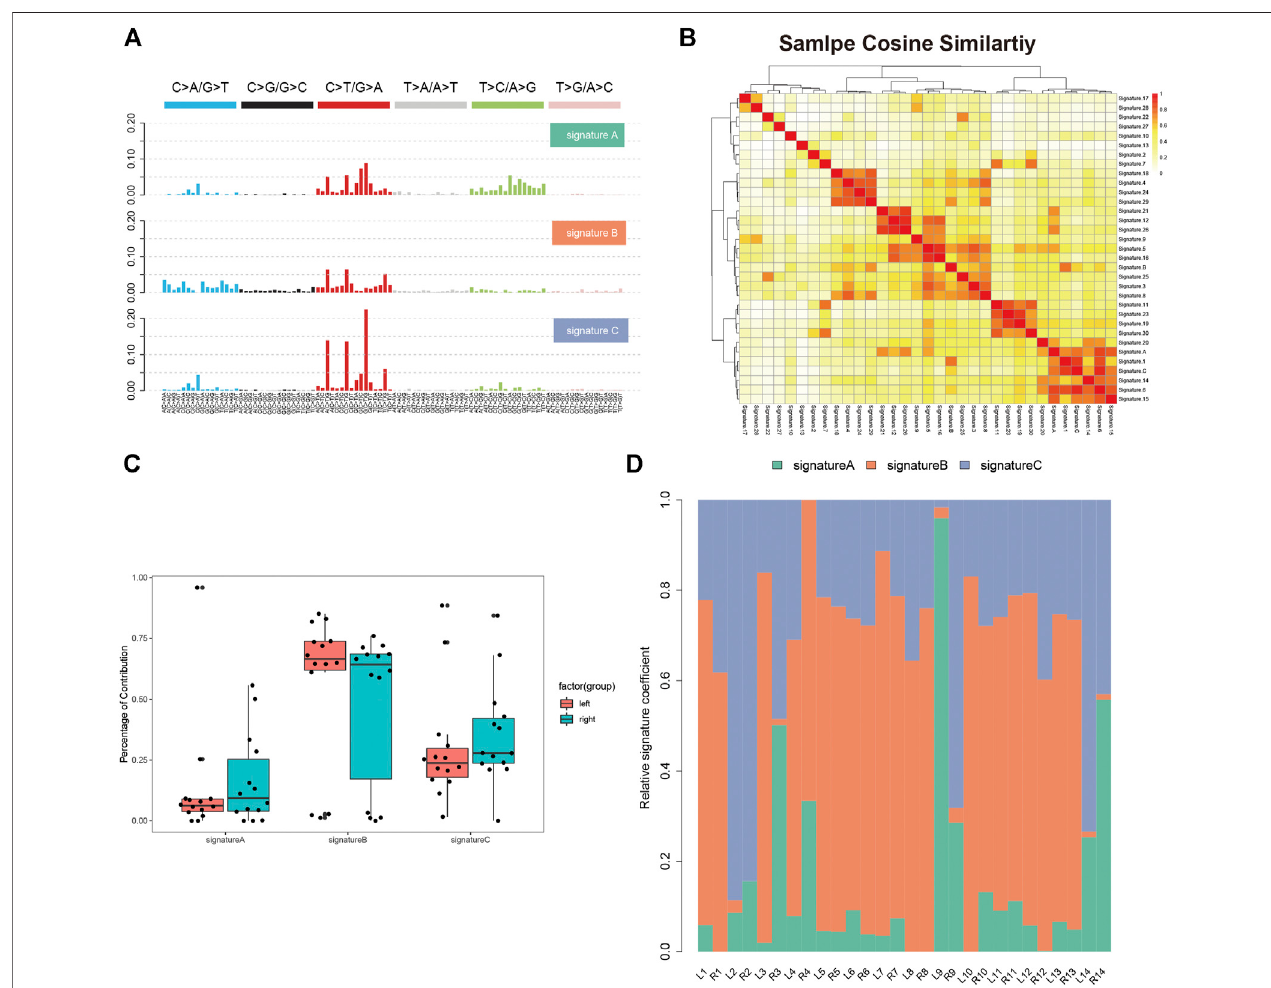
FIGURE1| SinglenucleotidevariantsanalysisofsRL-CC. (A) ThreeSNVsignaturesareobtainedfromWESdatain14sRL-CCpatients. (B) Correlationanalysisof threeSNVsignatureswithknown30signatures.Thebar representsthecoef fi cientindex. (C) Theboxplotshowsthepercentageofthethreesignaturesinleft-sidedand right-sidedlesionswhenanalyzedasawhole.SignatureA: p (cid:1) 0.722,two-tailedpairedttest;signatureB: p (cid:1) 0.539,two-tailedpairedttest;andsignatureC: p (cid:1) 0.589, two-tailed paired t test. (D) The distribution of the three signatures in two lesions of each patient is presented by the